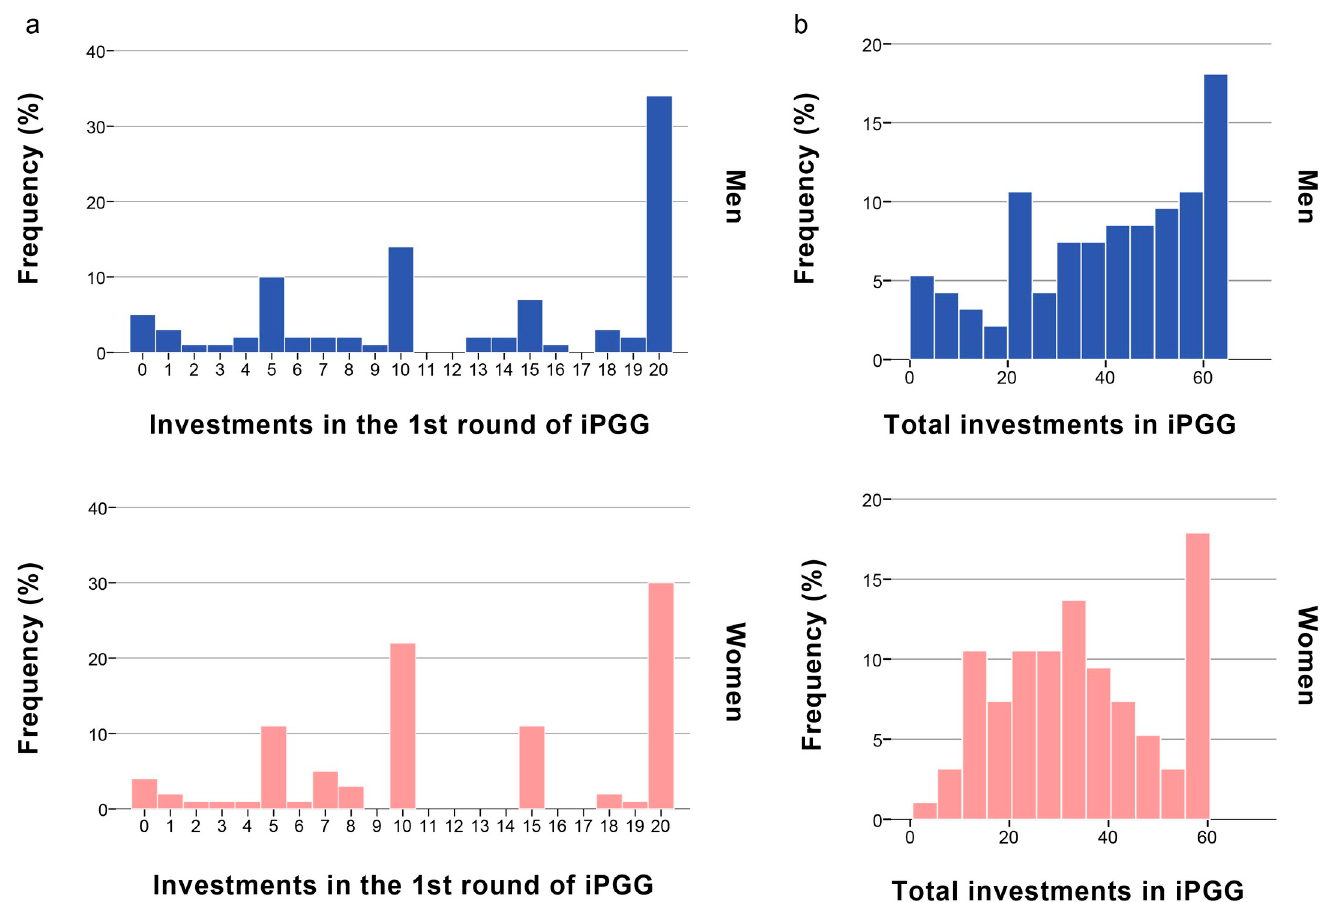
Fig 1. The frequency distribution of first (a) and total (b) investments in the iterated Public Goods Game among male and female participants. (a) Distributions of the first investments of men and women do not differ significantly: Mann-Whitney U-test: N = 189, U = 4297.5, p = 0.648; (b) distributions of the total investments of men and women do not differ significantly: Mann-Whitney U-test: N = 189, U = 3910.5, p = 0.139.